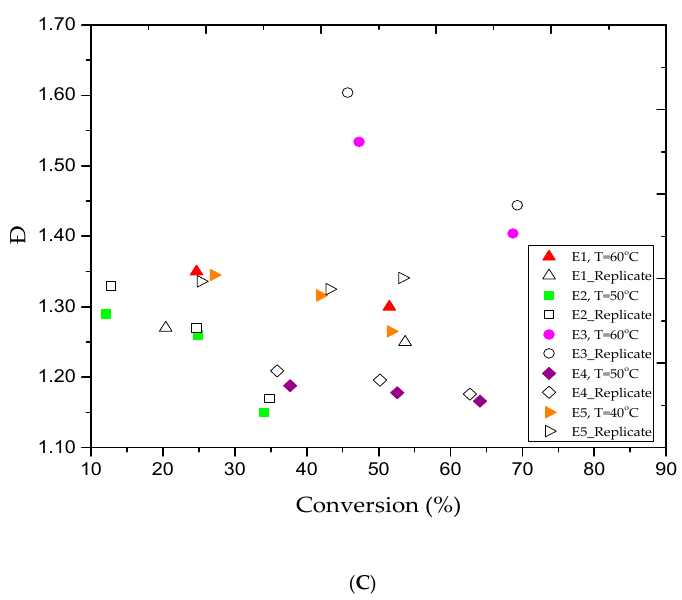
Figure 1. For experiments E1–E5: ( A ) methyl methacrylate (MMA) conversion versus reaction time, ( B ) variations of experimental number-average molar mass (M n ) versus methyl methacrylate (MMA) conversions, and ( C ) variations of the polydispersity index (Ð) versus methyl methacrylate (MMA) conversions. Table 2. Experimental results of the emulsion AGET ATRP of MMA using the dNbpy ligand.